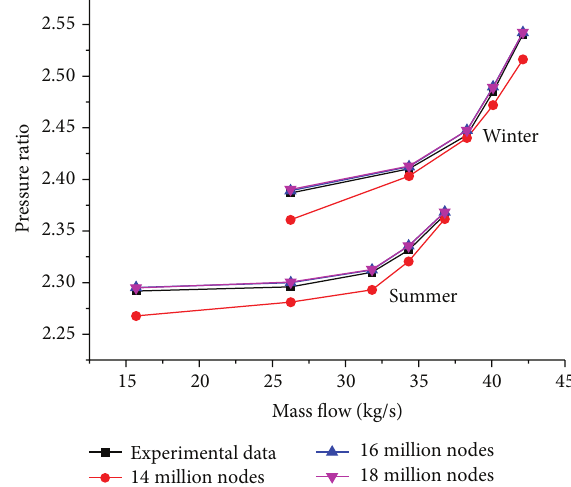
Figure 3: Comparison of pressure ratio curve in different number of grid nodes and experimental data.